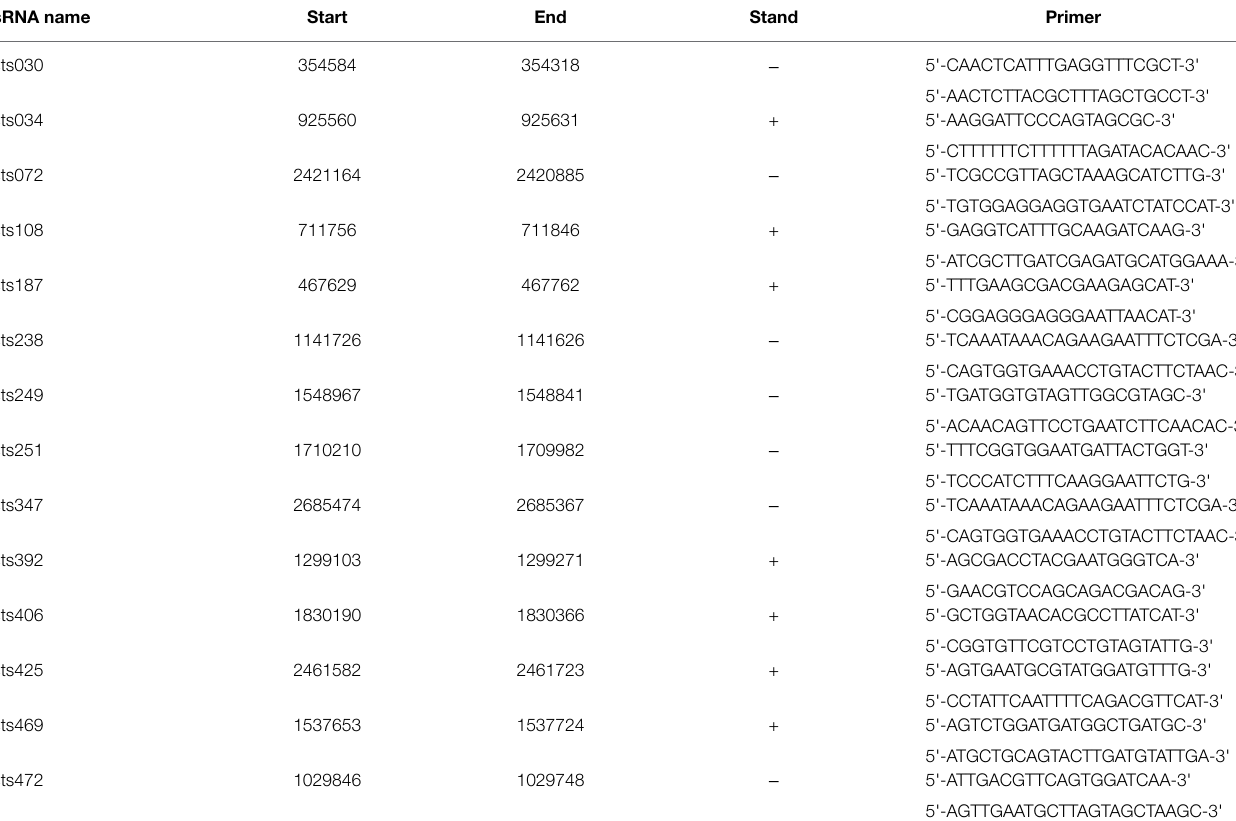
TABLE 1 | The 14 selected candidate sRNAs for RT-PCR